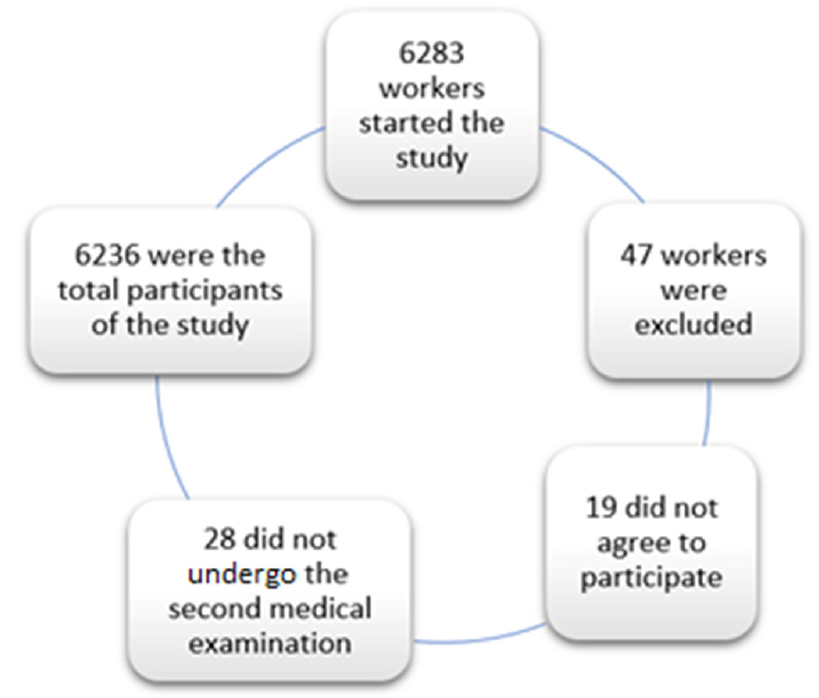
Figure 1. Flowchart of participants. Abdominal waist circumference was measured in cm with a measuring tape (SECA model 20, with an interval of 1–200 cm and millimeter division). The person stood feet together and trunk erect, abdomen relaxed, and upper limbs hanging on both sides of the body. The tape measure was placed parallel to the floor at the level of the last floating rib. Hip circumference was measured with a SECA model 200 tape with a measuring interval of 12–200 cm and millimeter division. The same position was adopted as for waist circumference and the measuring tape was passed horizontally at hip level. Waist/height and waist/hip indices were obtained by dividing waist circumference by height and hip circumference, respectively. The cut-off point for the former was 0.50 while for the latter it was 0.85 for females and 0.95 for males [33]. Blood pressure was measured in the supine position with a calibrated OMRON M3 automatic sphygmomanometer after 10 min of rest. Three measurements were taken at one-minute intervals and the mean of the three was calculated. Blood tests were ob- tained by peripheral venepuncture after a 12-h fast, sent to reference laboratories, and processed within 48–72 h. Automated enzymatic methods were used for blood glucose, to- tal cholesterol, and triglycerides. Values are expressed in mg/dL. HDL was determined by precipitation with dextran sulphate Cl2Mg, and values are expressed in mg/dL. LDL was calculated using the Friedewald formula (provided triglycerides were less than 400 mg/dL). Values are expressed in